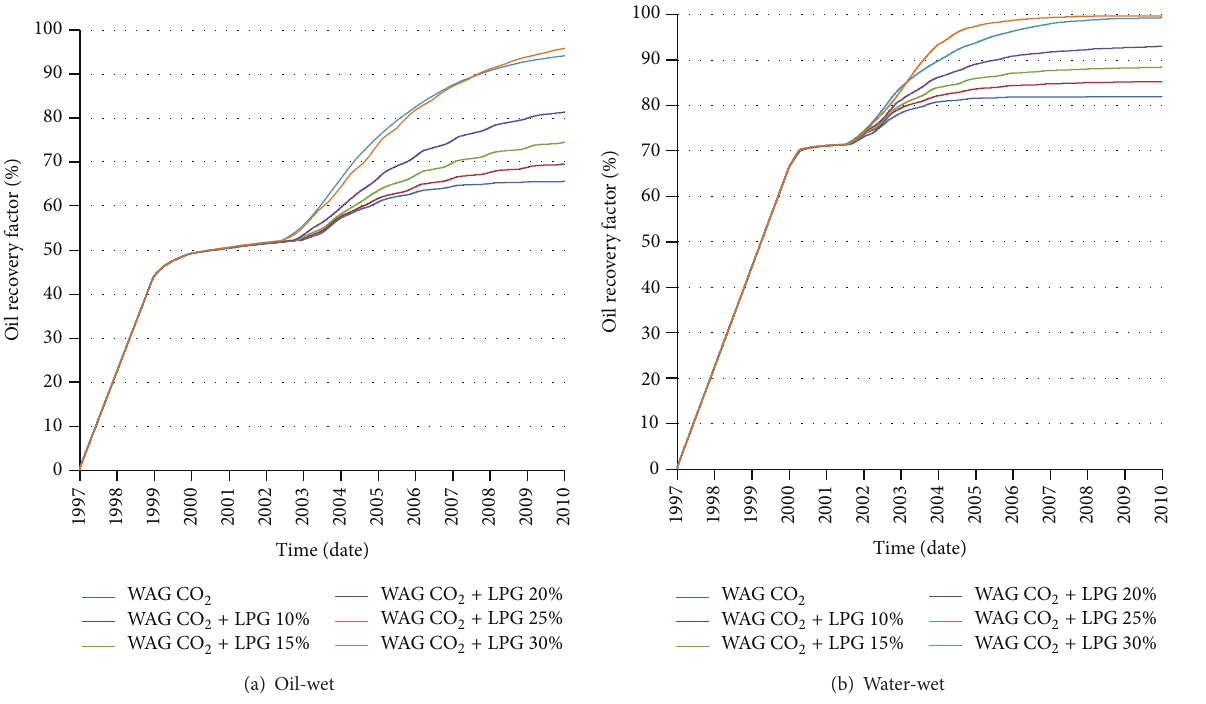
Figure 5: Oil recovery factors with LPG mole fraction of injection gas for different wettability conditions (composition of LPG: propane 63%, butane 37%).